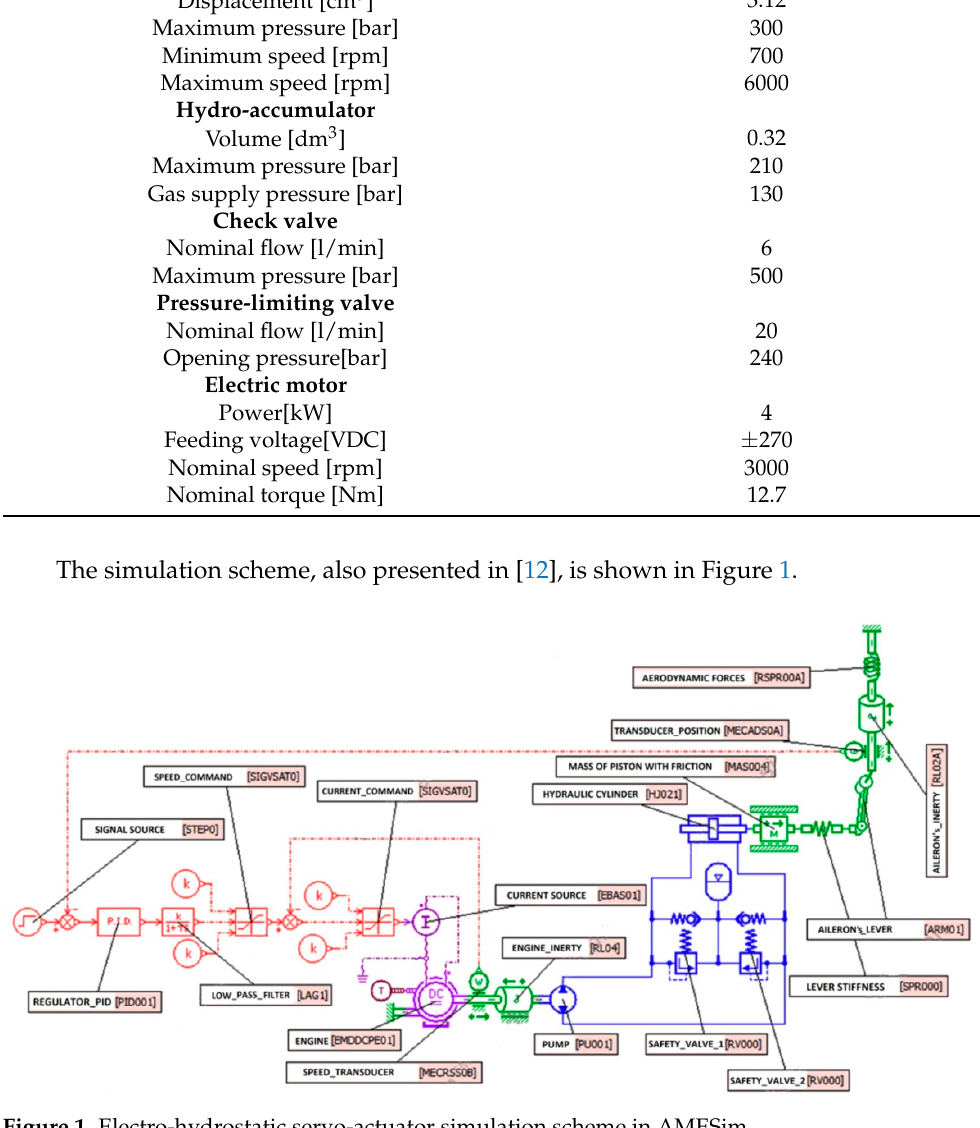
Figure 1. Electro-hydrostatic servo-actuator simulation scheme in